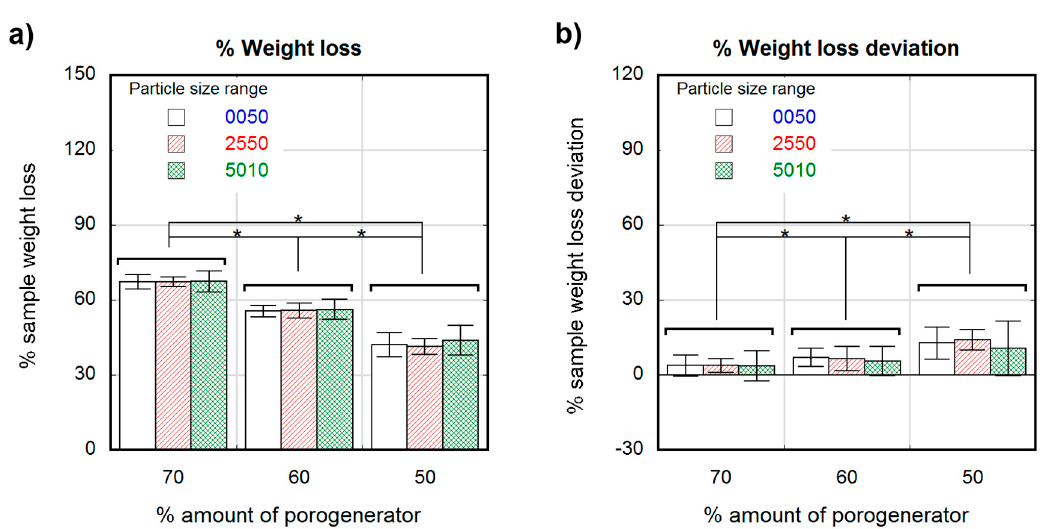
Figure 1. Percental weight loss after leaching of samples containing di ff erent salt particle sizes (white 0–50- µ m, stripe pattern 25–50- µ m and cross pattern 50–100- µ m) as a function of the theoretical percental amount of porogenerator ( a ); Percental deviation from theoretical to experimental weight loss of samples containing di ff erent particle sizes (white 0–50- µ m, stripe pattern 25–50- µ m and cross pattern 50–100- µ m) as a function of the theoretical percental amount of porogenerator ( b ). Significance level according to the Student t -test * p < 0.05.